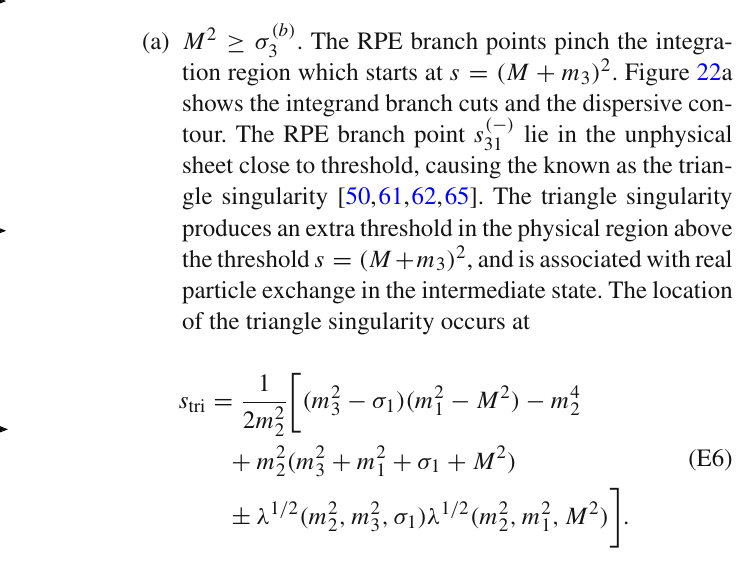
Fig. 22 Contours for dispersive triangle Eq. (56) shown in red, and the ( b ) ( a ) ≤ M 2 ≤ σ ( b ) integrand cuts. The three cases are a M 2 ≥ σ , b σ , 3 3 3 ( th ) ≤ M 2 ≤ σ ( a ) and c σ . Case a corresponds to the usual triangle 3 3 singularity, which occurs since the OPE branch points pinch the inte- gration region. Case c happens when the initial state of the OPE has a higher threshold then the intermediate state. The blue region indicates the physical region from the initial threshold. Note that a triangle sin- gularity does not occur in this case and the integration is not